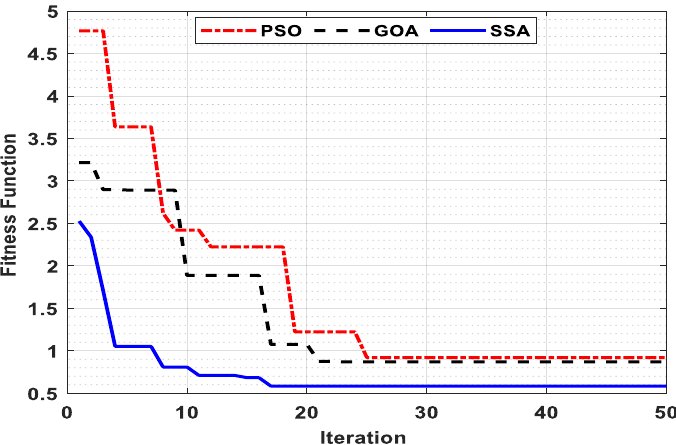
Figure 9. Convergence profile for PSO, GOA and SSA.